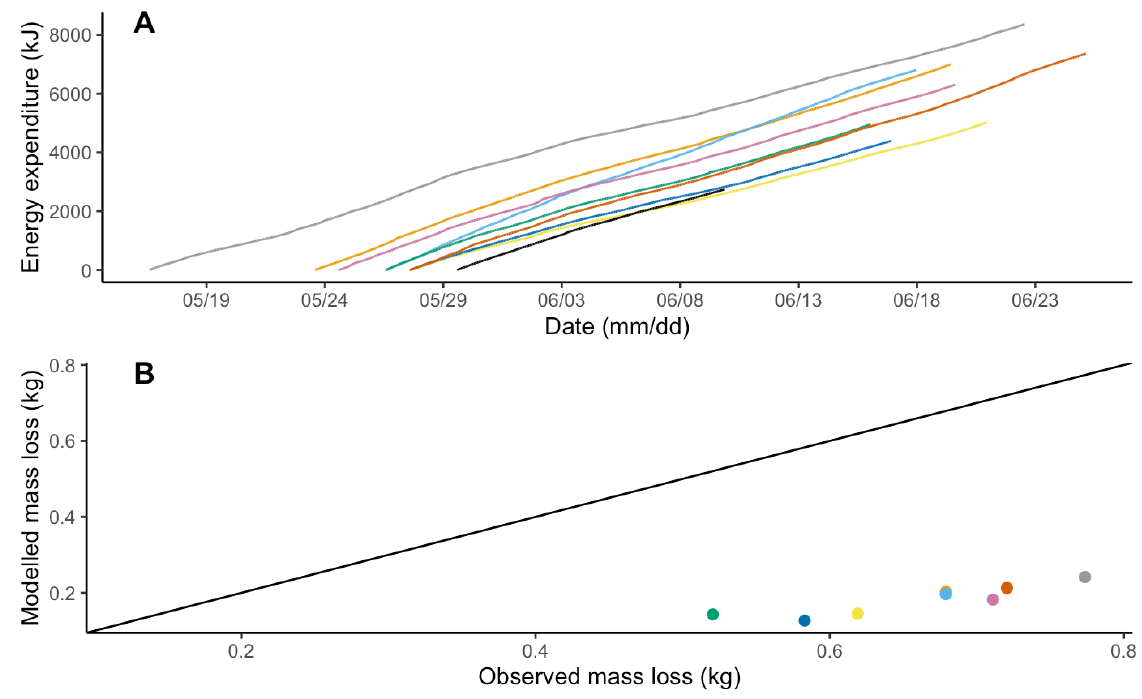
Figure 4. A. Energy expenditure over the spawning season for nine female Allis shad, estimated from temperature and tail beat frequency using equations (1) and (2). B. Observed mass loss and mass loss modelled with equations (1) and (2) over the spawning season. The straight line in B is the one on which points should lie if the modelled mass loss would fit the observations. Colours are as in Fig. 3, with black line in A for the individual whose tag stopped recording before the end of the